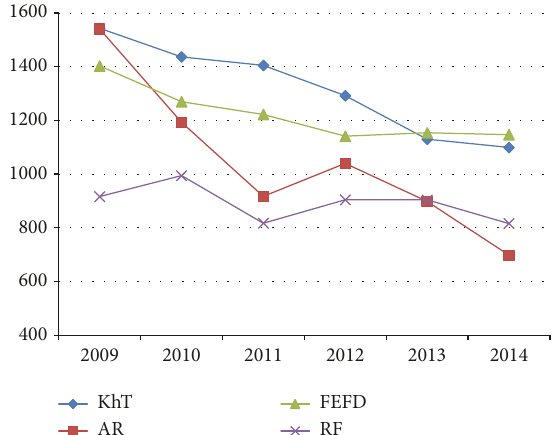
Figure 4: Dynamics of pneumonia morbidity of children’s population on the territory of the Far East Federal District (per 100 000 children’s population); KhT: Khabarovsk Territory, AR: Amur Region, FEFD: Far East Federal District, and RF: Russian